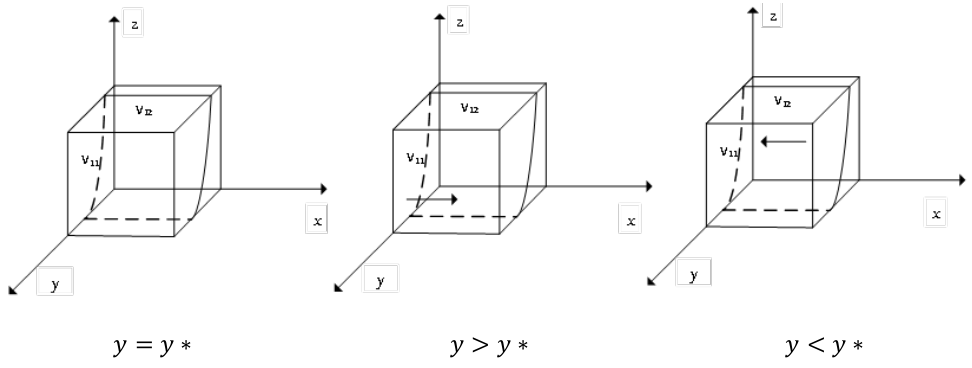
Figure 1. Evolutionary phase diagram of enterprise stabilization